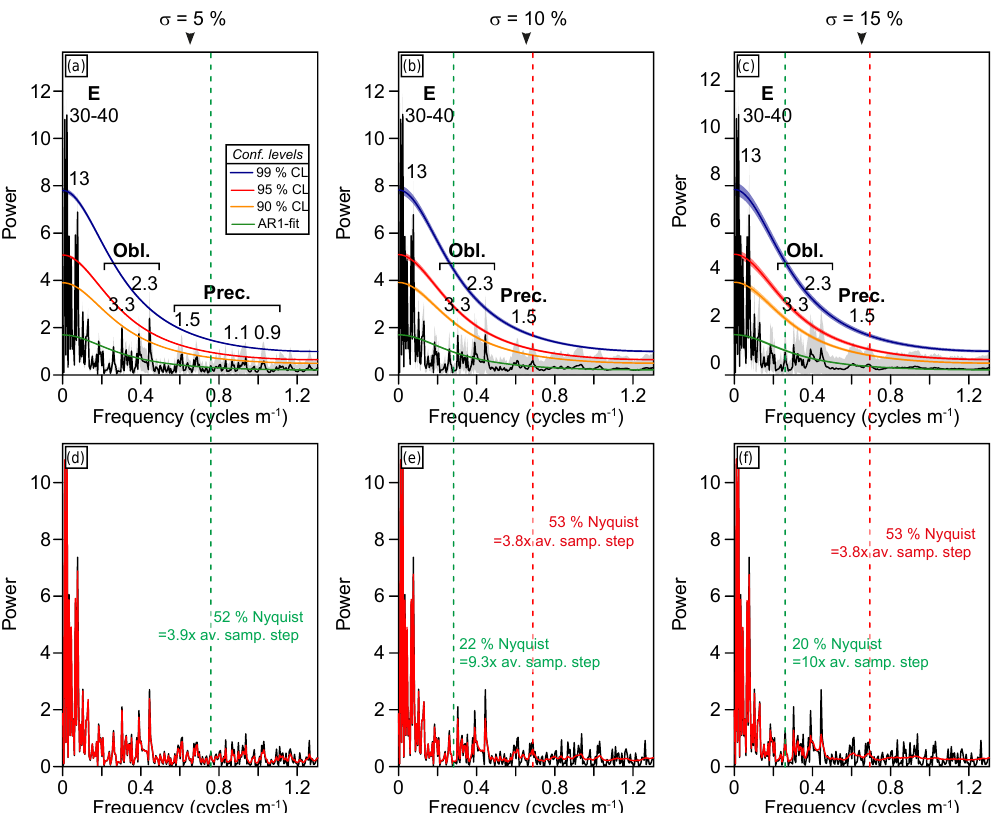
Figure 11. Effect of the gamma-law randomisation of the sample distances on the REDFIT spectrum of the La Charce series. Panels a to c : REDFIT spectra with a level of stratigraphic uncertainty fixed to 5, 10 and 15% of the average sample distance of the series. The grey area represents the interval covering 95% of the simulations. The average confidence levels are reported on the spectra with their respective areas covering 95% of the simulations. Main significant periods are indicated in metres with, in bold, their corresponding orbital cycles. E: 405kyr eccentricity; e: 100kyr eccentricity. Panels d to f : superposition of the REDFIT spectra before randomisation (in black) and the average spectrum after the 1000 simulations (in red). The red dashed lines indicate the lowest frequency above which the spectrum is completely smoothed, so that no other frequency can be identified. The green dashed lines represent the highest frequency below which the spectrum of the series before randomisation appears practically identical to the spectrum after